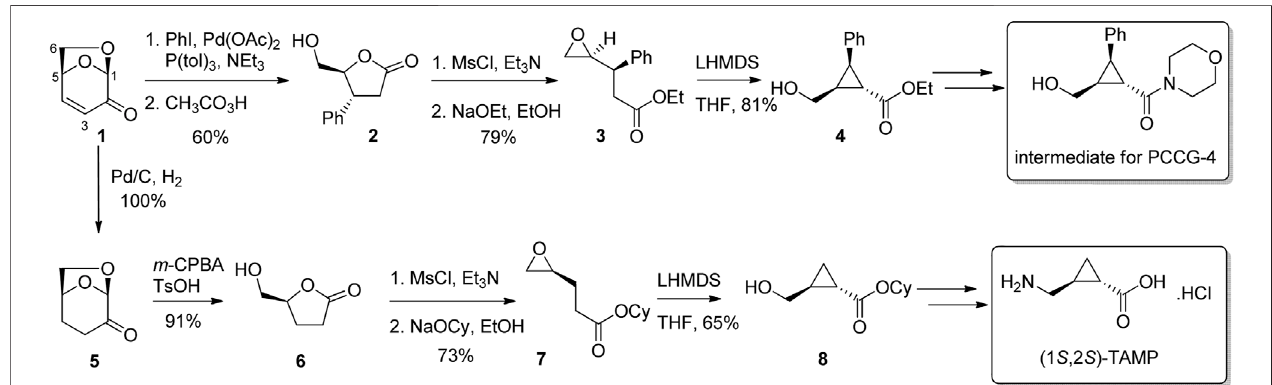
FIGURE 2 | Preparation of bioactive cyclopropanes from